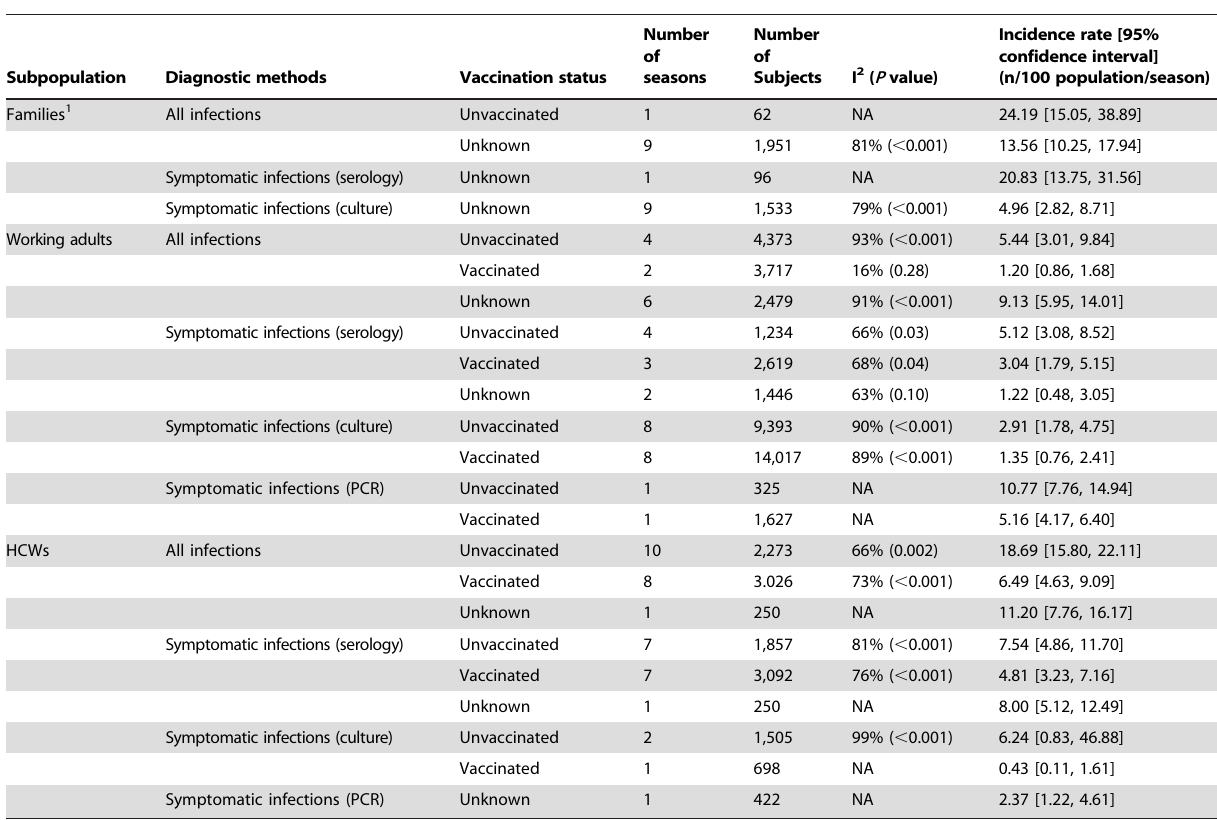
Table 1. Influenza incidence rates according to subpopulation, diagnostic methods and vaccination status.